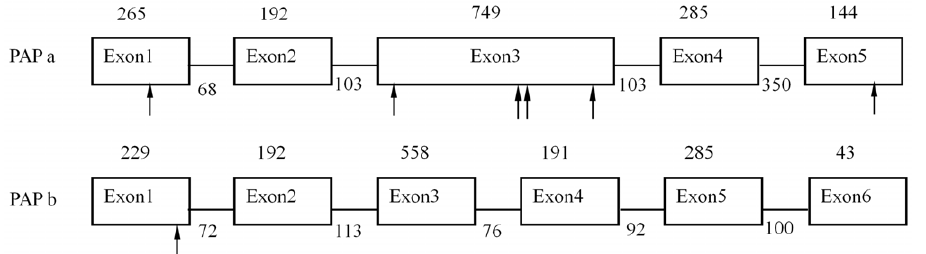
Figure 3. Gene structure and diversity of HvPAPa and HvPAPb in barley, with exons (boxes), introns (thin lines) and SNPs (arrows) found between Yerong and Franklin. Those two genes were based on the sequences of Franklin. For HvPAP a (Genebank: JF274704), the length of intron 2 and 3 was 105 and 109 bp for Yerong, respectively. The synonymous substitutions of HvPAP a were CAC/CAT, TAC/TAT, TCA/TCG, GAA/ GAG, ACG/ACC and GTT/GTC from left to right for Franklin/Yerong, respectively. For HvPAP b (Genebank: JF274705), only part of exon1 and exon6 was sequenced for both cultivars with the synonymous substitution being CCT/CCC for Franklin/Yerong.